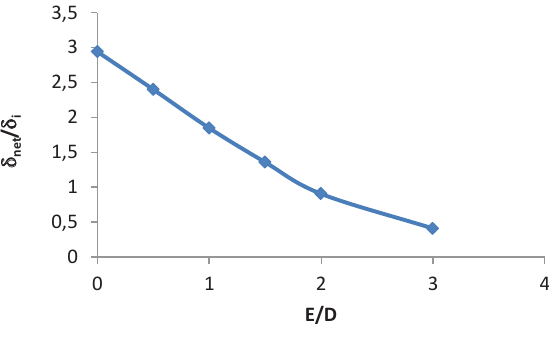
Fig. 11 Variation of normalized net pile head settlement with E/D at the end of tunnel excavation (Y/D= +5).